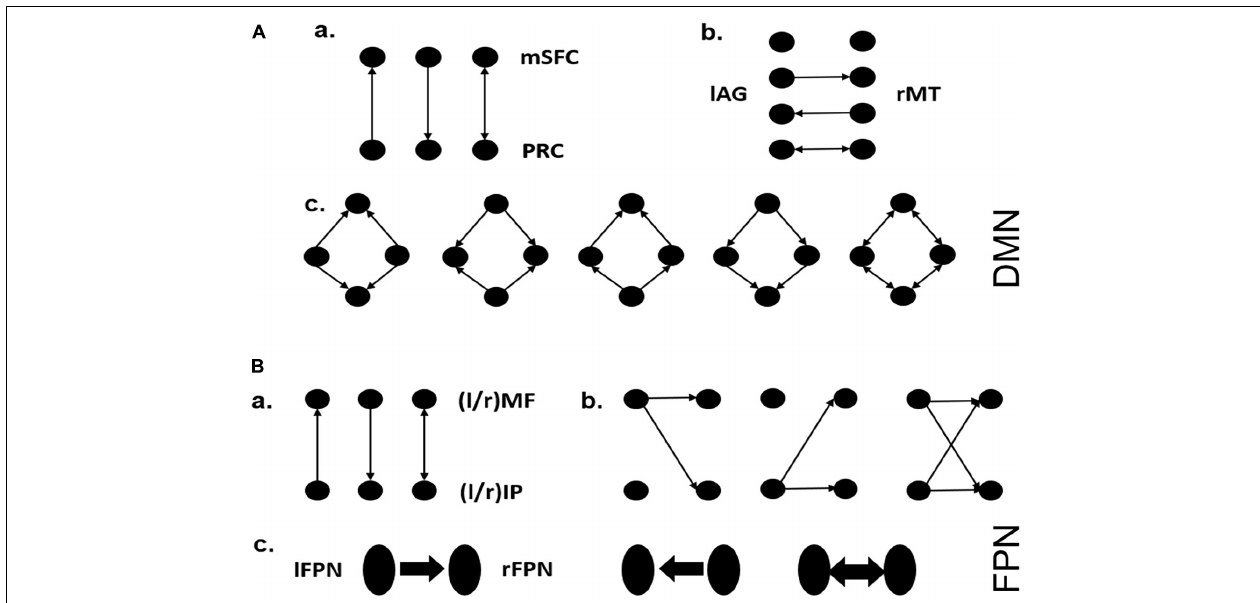
FIGURE 2 | Model hypothesis for DMN and FPN. (A) a: Possible interaction pathways between mSFC and PRC, assuming they are directly connected. b: Possible interaction pathways between lAG and rMT. c: The symmetrical connections between the four brain regions, except for the connections involved in a and b. These assumptions yielded 60 possible dynamic causal modeling structures. (B) a: Possible interaction pathways between lMF and lIP (or rMF and rIP), assuming they are directly connected in each side of the FPN. b: The way one side of the FPN controls the other side via one or both nodes. c: The directionality by which one side of the FPN controls the other side via left to right or right to left or both directions. These assumptions yielded 81 possible dynamic causal modeling